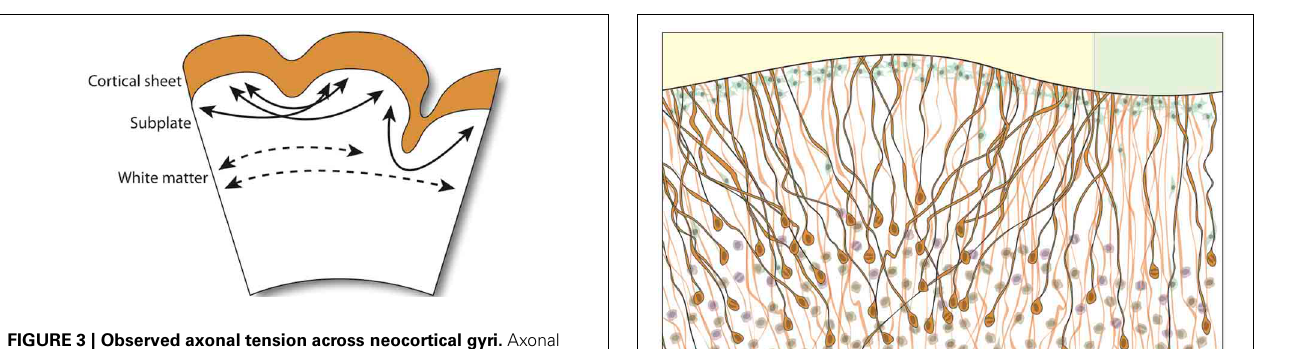
FIGURE 3 | Observed axonal tension across neocortical gyri. Axonal tension (arrows) is distributed circumferentially across the subcortical white matter (dashed arrows), but radially in the subplate and gyral folds (filled arrows). Contrary to the connectivty-driven hypothesis (see section 4), circumferential tension is not observed across neocortical gray matter (Xu et al., 2010).